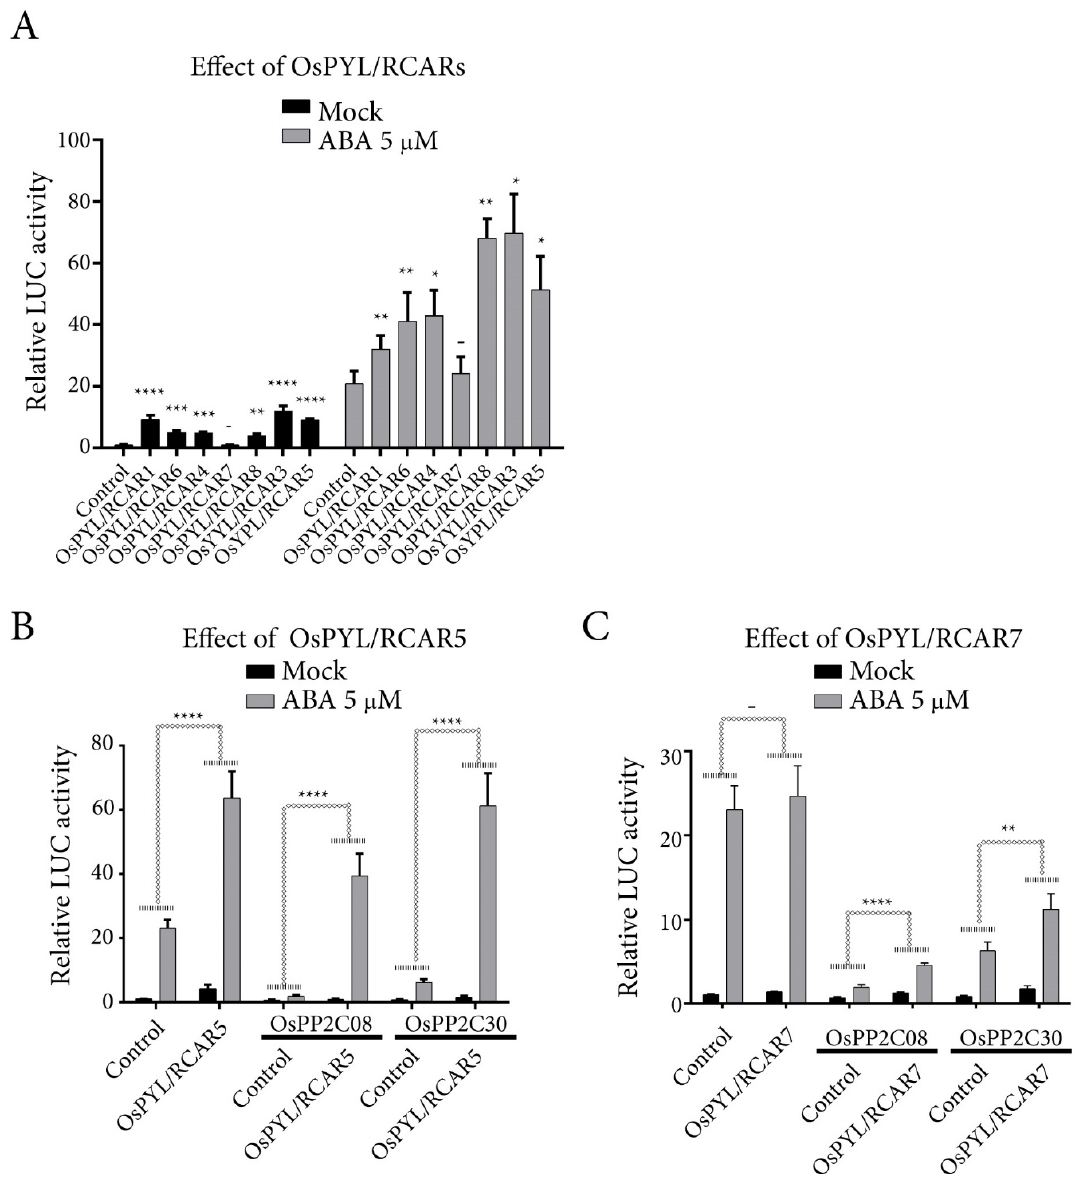
Figure 6. OsPYL / RCAR7 showed the lowest activity among monomeric ABA receptors. ( A ) Comparative Figure 6. OsPYL/RCAR7 showed the lowest activity among monomeric ABA receptors. ( A ) analysis of ABA signaling e ff ects of monomeric ABA receptors under absence or presence of ABA. Comparative analysis of ABA signaling effects of monomeric ABA receptors under absence or Luciferase (LUC) assay was done using rice protoplasts, reporter, and ABA receptors as signaling presence of ABA. Luciferase (LUC) assay was done using rice protoplasts, reporter, and ABA e ff ectors. ( B , C ) Comparative analysis of OsPYL / RCAR7 and OsPYL / RCAR5 activity to suppress receptors as signaling effectors. ( B , C ) Comparative analysis of OsPYL/RCAR7 and OsPYL/RCAR5 individual phosphatase PP2C08 and OsPP2C30. Luciferase assay was done using rice protoplasts, activity to suppress individual phosphatase PP2C08 and OsPP2C30. Luciferase assay was done using reporter, OsPP2CAs, and ABA receptors. Luciferase activity was measured by comparing with rice protoplasts, reporter, OsPP2CAs, and ABA receptors. Luciferase activity was measured by co-transformed marker (Ubi::rLUC), fLUC / rLUC. Values represent averages and error bars are SD ( n = 3). comparing with co-transformed marker (Ubi::rLUC), fLUC/rLUC. Values represent averages and These experiments were repeated three times. Results showed similar patterns and representative error bars are SD ( n = 3). These experiments were repeated three times. Results showed similar results were presented. – means that p -value is more than 0.05, * means that p -value is less than 0.05, patterns and representative results were presented. – means that p -value is more than 0.05, ** means ** means that p -value is less than 0.01 and **** means that p -value is less than that p -value is less than 0.01 and **** means that p -value is less than 0.0001.